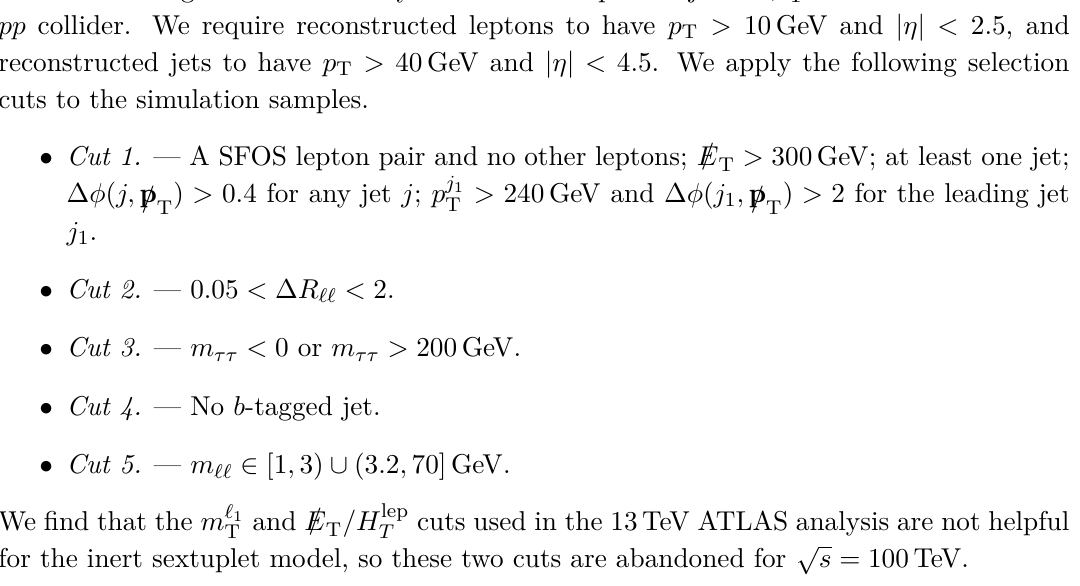
analysis [91] (monojet + /E T T